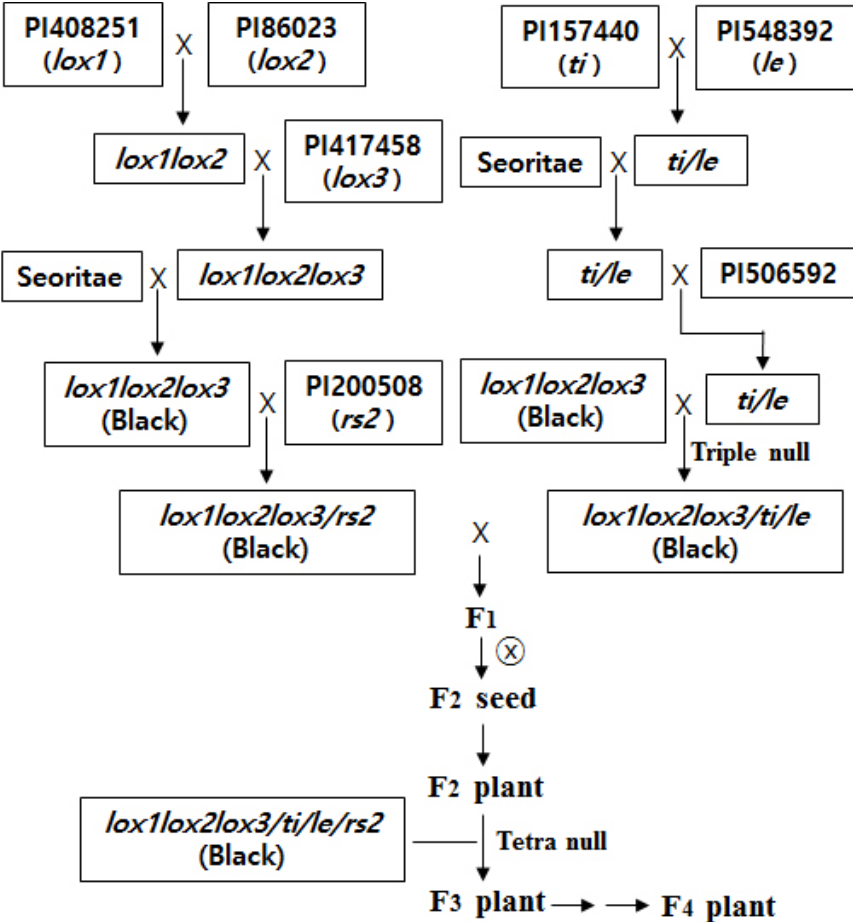
Figure 1. Scheme for development of a tetra null genotype ( lox1lox2lox3 / lox1lox2lox3 - ti / ti - le / le - rs2 / rs2 ) with a black seed coat and green cotyledon using eight soybean